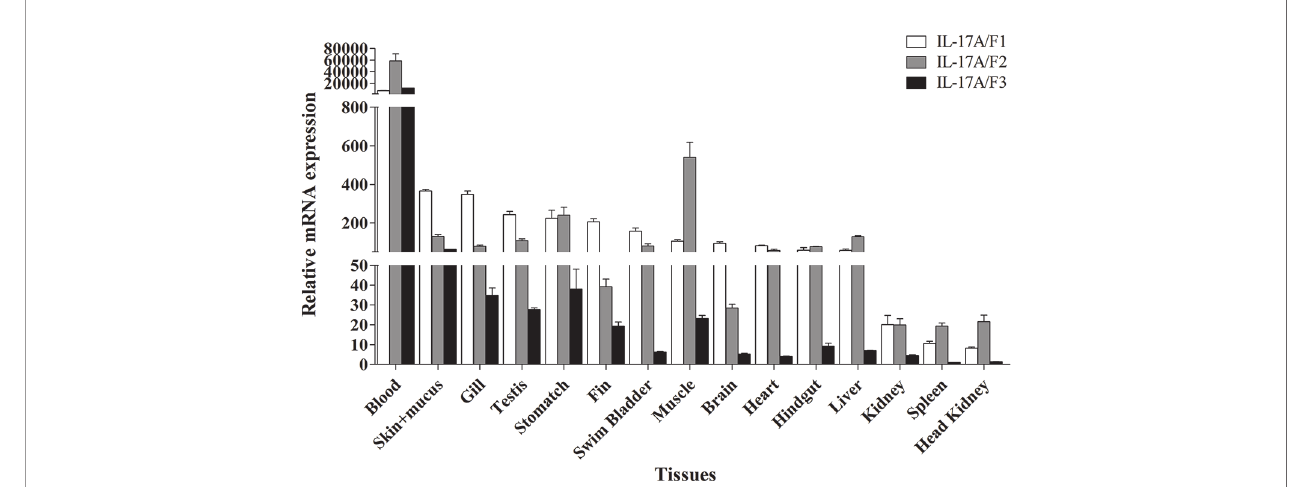
FIGURE 4 | Tissues expression levels of Pf _IL-17A/F1, Pf _IL-17A/F2 and Pf _IL-17A/F3 mRNAs in adult yellow cat fi sh blood, swim bladder, skin+mucus, hindgut, liver, stomach, brain, gill, spleen, head kidney, muscle, heart, testis, fi n and trunk kidney. The mRNA expressions of three IL-17A/F genes were detected using qPCR and normalized to the internal gene b -actin. Columns represent the means for each treatment ( n = 3). Error bars represent standard error of the